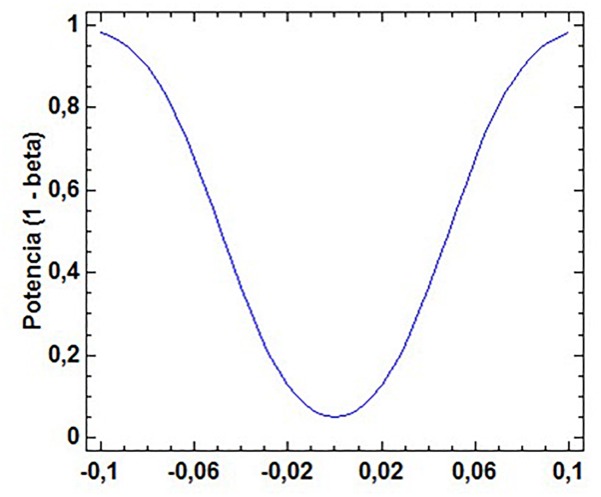
Proportion analysis for the UEFA Euro 2008 and UEFA Euto 2016 samples. Power curve (alpha = 0.05, average ratio = 0.381012).